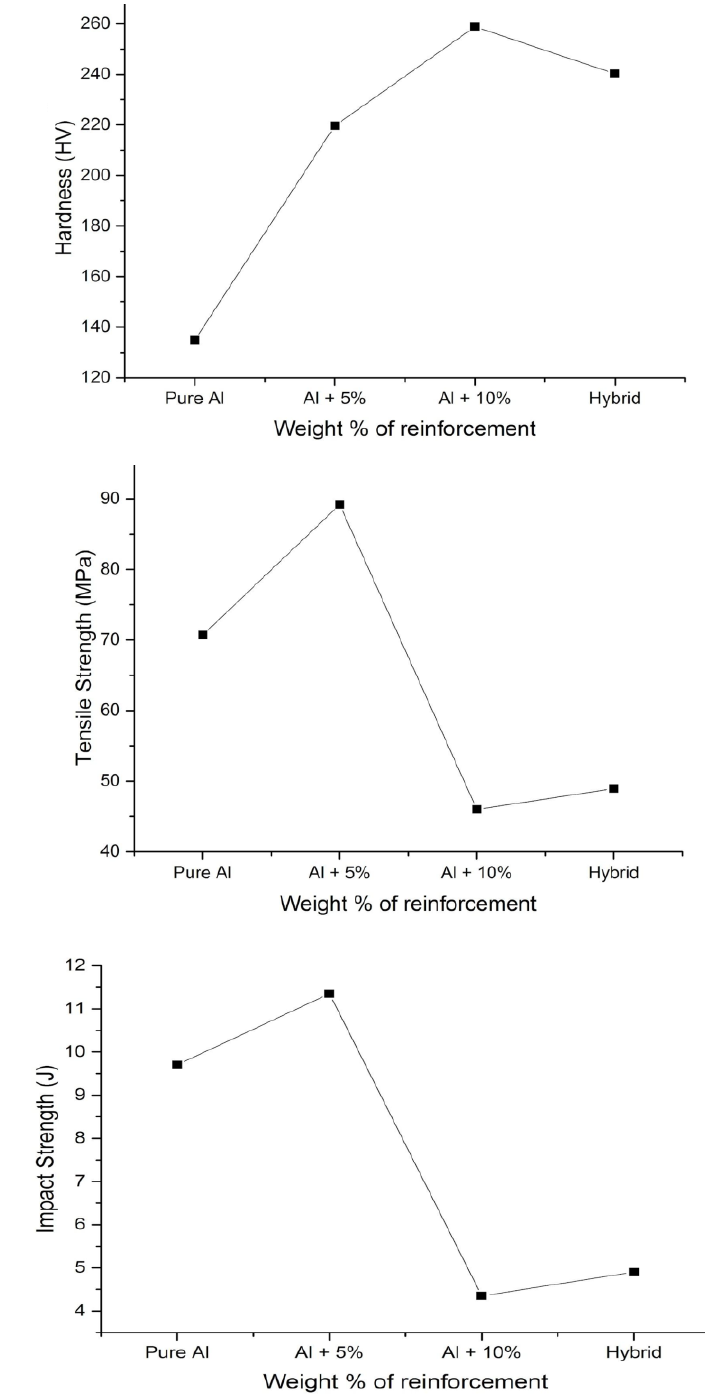
Figure 5. Mechanical properties of the composites and its hybrids: ( a ) hardness, ( b ) tensile strength, ( c ) impact ( c ) impact strength.